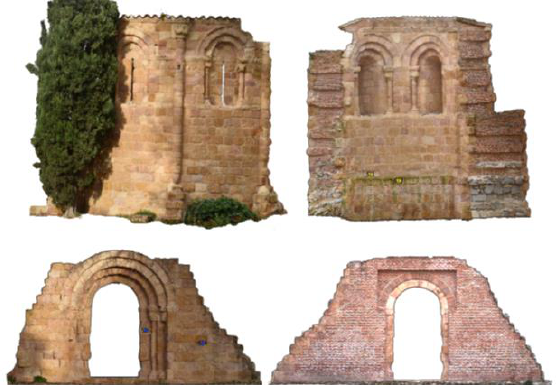
Figure 15. Location of the samples. In yellow the samples SI-1 and SI-2 and in blue the Samples SI-4 and